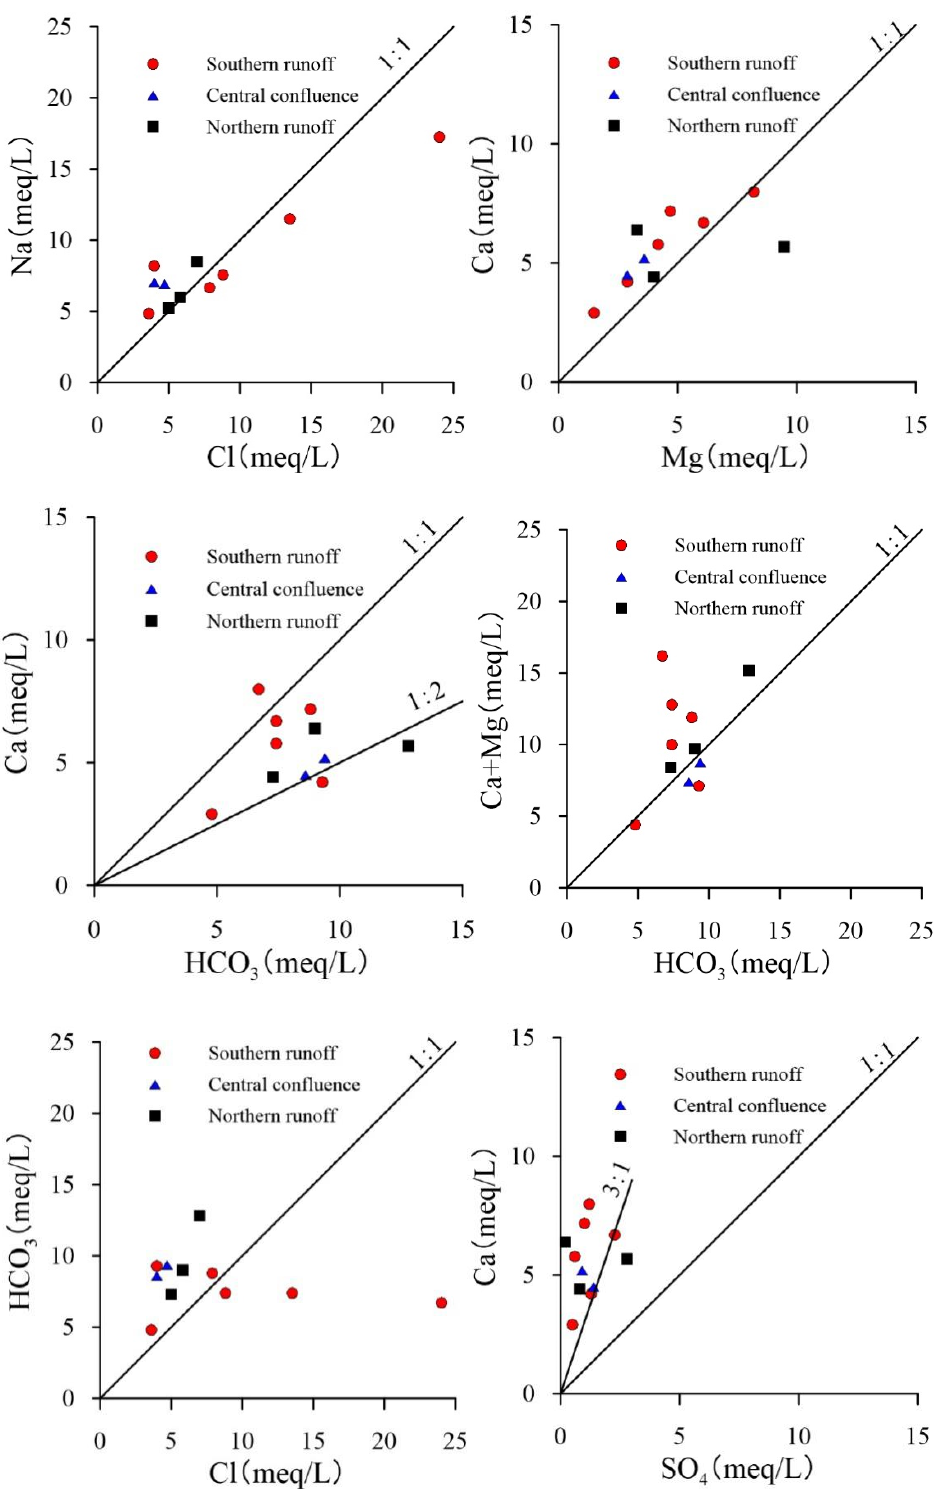
Figure 13. Bivariate diagrams of ionic concentrations in groundwater.